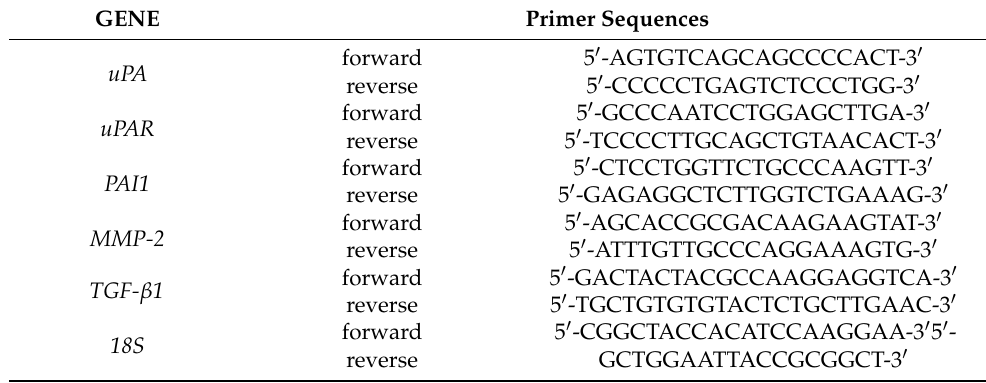
Table 1. List of primers used and their